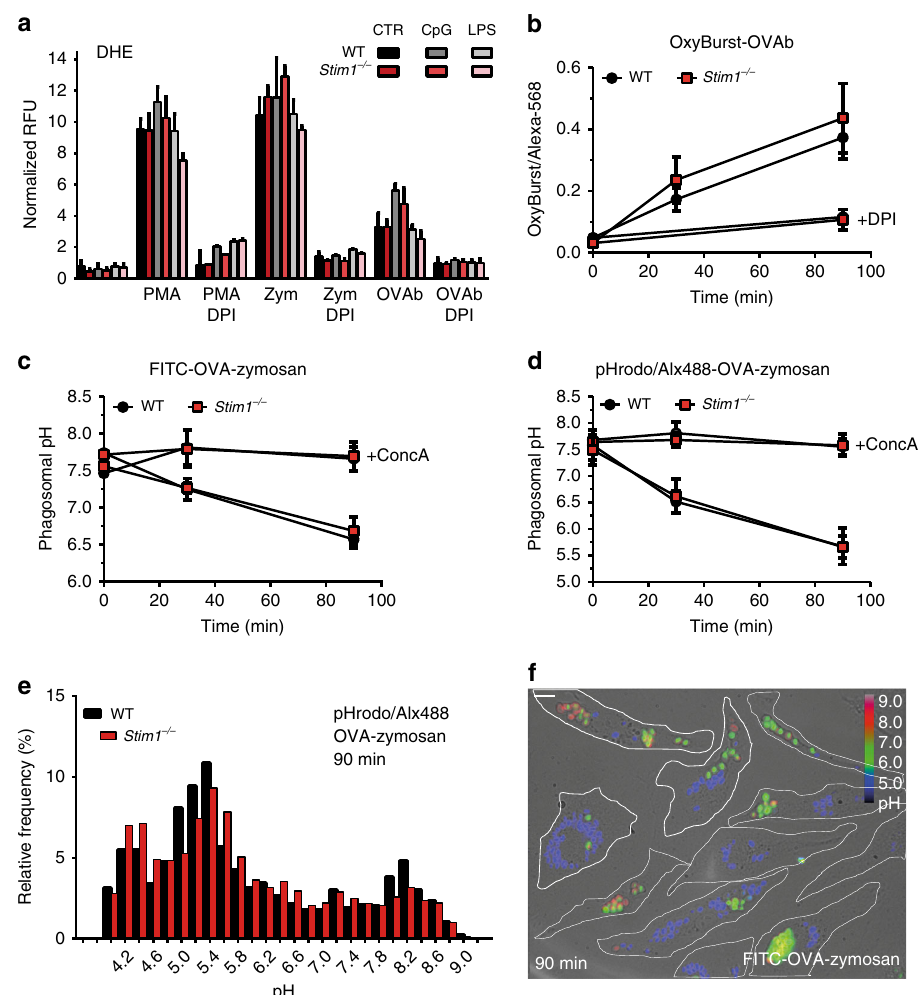
Fig. 6 Stim1 ablation does not affect ROS production or phagosomal pH. a Intracellular ROS production was measured in immature and CpG or LPS- matured BMDCs loaded with 30 μ M DHE, and exposed to OVA-coated beads (OVAb), zymosan (Zym) or 100 nM PMA. N = 4, triplicate wells. b ROS production during phagocytosis (30 and 90 min) was assessed by exposing BMDCs to OVAb coupled to OxyBurst and Alexa-568. In a and b , DPI (10 μ M) blocked the DHE or OxyBurst signal, but no differences were detected upon Stim1 ablation. N = 6/4/4 coverslips containing 84/54/58 (WT) or 85/50/53 ( Stim1 − / − ) cells, for 30 min/90 min/DPI. c , d Phagosomal acidi fi cation (30 and 90 min) was measured using ratiometric or pseudo-ratiometric imaging by exposing cells to FITC-coupled ( c ) and pHrodo/Alexa-488-coupled ( d ) OVA-coated zymosan, respectively. Phagosomal acidi fi cation was blocked by ConcA (0.2 nM), but there were no differences upon Stim1 ablation. N = 3 coverslips for all conditions, comprising 3218/2826/1713/3533 (WT) or 2722/ 5295/2608/4438 ( Stim1 − / − ) FITC-phagosomes, and 2612/2194/700/746 (WT) or 1740/2218/670/862 ( Stim1 − / − ) pHrodo phagosomes, for 30 min/ 90 min/30min ConcA/90 min ConcA. e Histogram of all combined 90 min pHrodo phagosomal pH values for WT and Stim1 − / − BMDCs shows the broad and bimodal distribution of phagosomal pH in these cells. f Measurements of phagosomal pH by microscopy revealed the heterogeneity of the pH of individual phagosomes even within the same cell. Cells are outlined in white, the image is a merge of the bright fi eld and 480/440 colour-coded ratio channels 90 min after addition of FITC-OVA-zymosan. pH values obtained from calibration curves (Supplementary Fig. 6b) are matched to the ratio colour-coded bar. Phagocytic targets added at 20:1 targets:cells. White bar = 10 μ m. Error bars are means ±